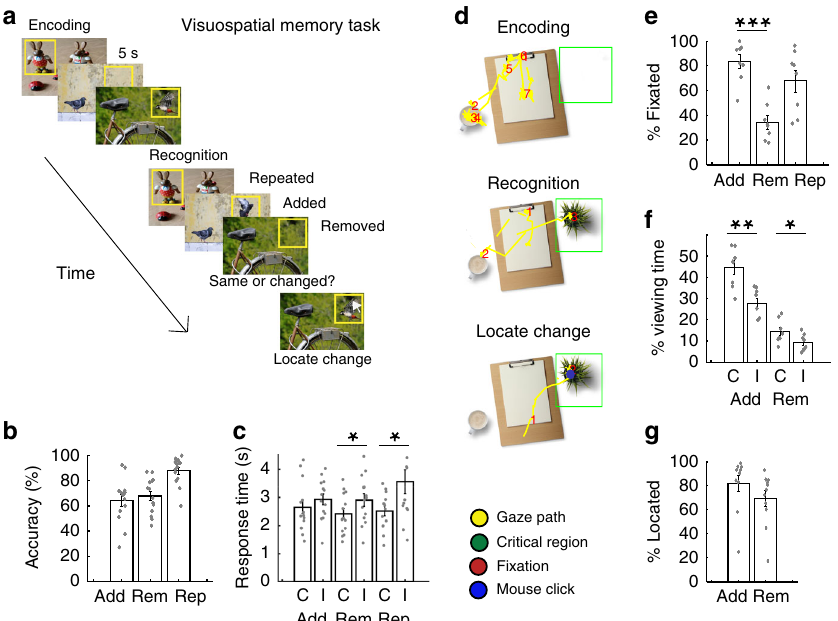
Fig. 1 Visuospatial memory task. a Participants viewed and encoded into memory a series of images. During recognition testing, participants indicated whether the images were manipulated (items added or removed) or whether they were identical to the encoded images. Participants subsequently identi fi ed the location of the manipulation using a mouse click. b Probability of successful recognition for the added (Add), removed (Rem), and repeated (Rep) conditions across participants. c Mean response times for correct (C) and incorrect (I) responses for added, removed, and repeated conditions across 14 participants. Response times were signi fi cantly faster when participants correctly recognized removed and repeated images compared to when they were incorrect (removed, t (13) = − 2.31, p = 0.038, repeated t (12) = − 2.85, p = 0.014). d Representative eye-movements during encoding, recognition, and identi fi cation of the location of the manipulation. We converted the gaze path (yellow) into fi xations (red) and calculated the percentage of fi xations within the critical region of each image (green box). e Probability of fi xation within the critical region for correctly recognized added, removed, and repeated items across 8 participants. We selected a random item as the critical region for the repeated condition to assess the probability of baseline fi xations. Participants spent at least one fi xation on a greater percentage of the successfully recognized added compared to removed items ( t (7) = 11.2, p = 10 − 5 ). f Probability of viewing time within critical region for correctly and incorrectly identi fi ed images across 8 participants. Participants spent a greater percentage of time viewing both the added item and the region of the removed item during correct compared to incorrect trials (added, t (7) = 4.93, p = 0.002; removed, t (7) = 2.52, p = 0.040). g Probability of mouse click within critical region for correctly recognized added and removed conditions across participants. All error bars indicate standard error of mean. Asterisks (*, **, ***) indicate signi fi cance at p < 0.05, p < 0.01, and p < 0.001, respectively; two- sided paired t